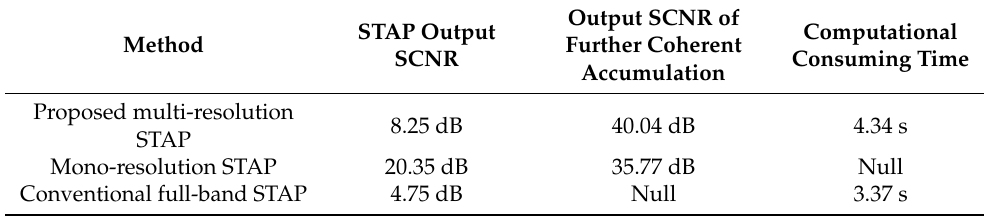
Table 5. SCNR Performance